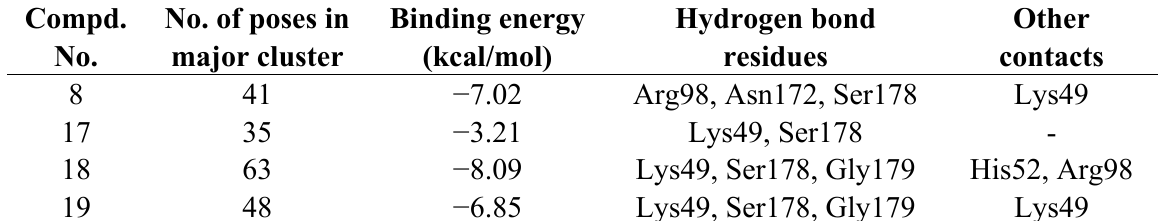
Table 2. Output for the docking of compounds 8 , 17-19